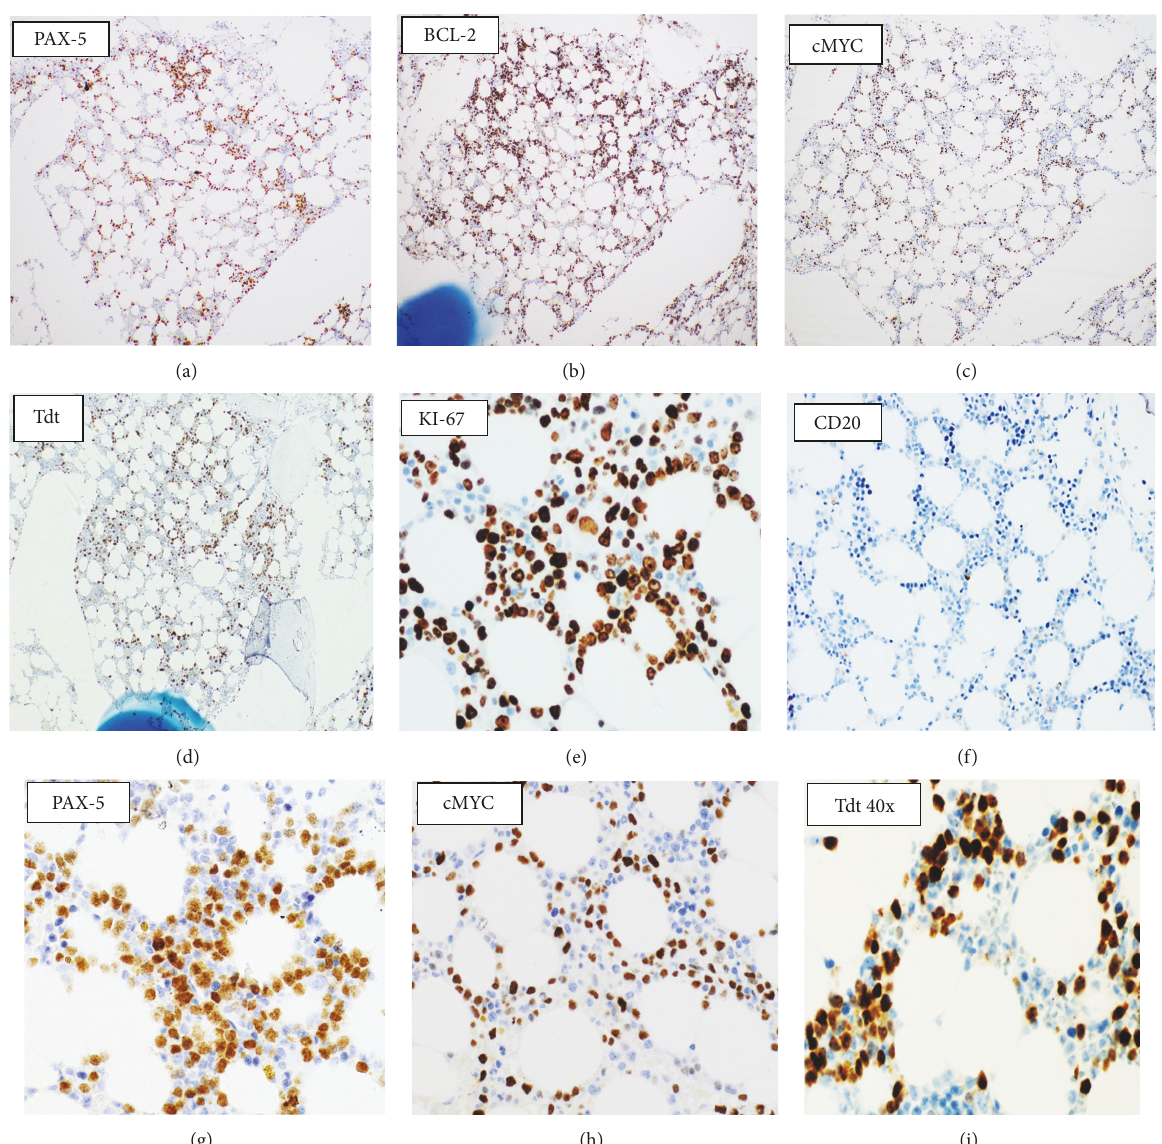
Figure 4: Immunohistochemistry performed on bone marrow biopsy (first relapse). The abnormal lymphoid cells are positive for PAX-5, BCL-2, cMYC , and TDT (a–d). KI-67 shows high proliferative index (e). The neoplastic cells are negative for CD20 (f). PAX-5 50x (g), cMYC 40x, and Tdt 40x